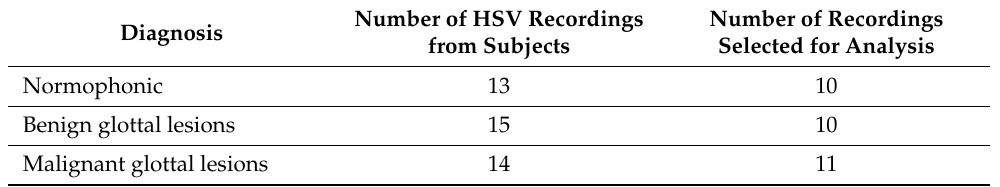
Table 1. Analyzed